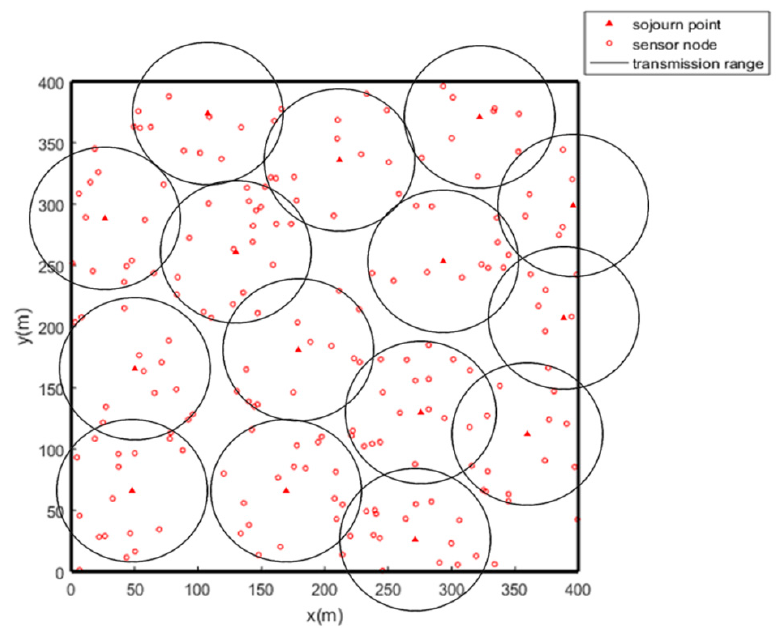
Figure 8. SPs selection using PSO.